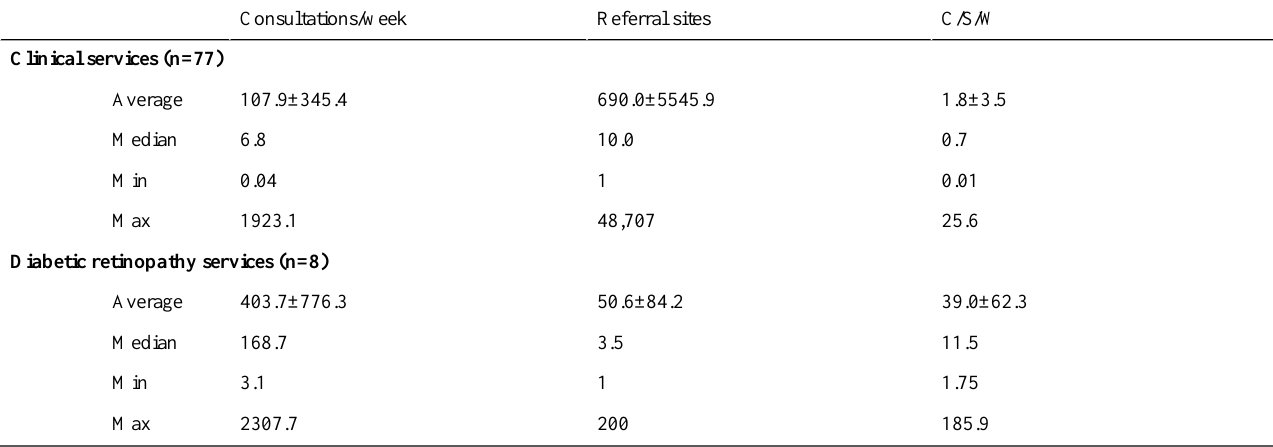
Table 2. The number of consultations per week, the number of referral sites in the program, and the number of C/W/S expressed as the average (±standard deviation), median, minimum, and maximum for 77 clinical services and 8 diabetic retinopathy screening services.